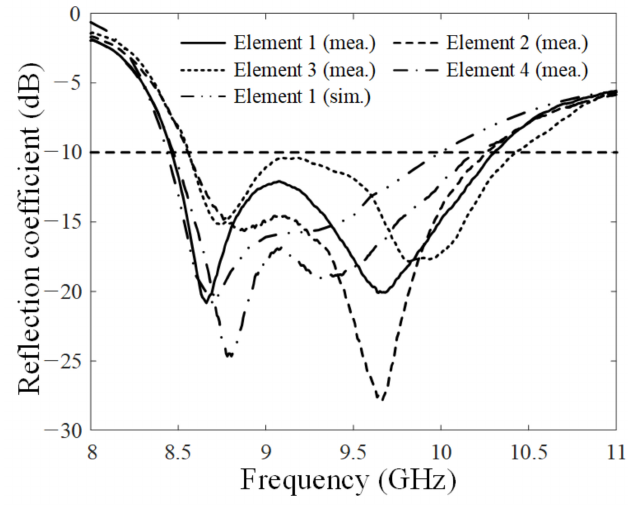
Figure 8. Reflection coefficients of the 2 × 2 X-band array.